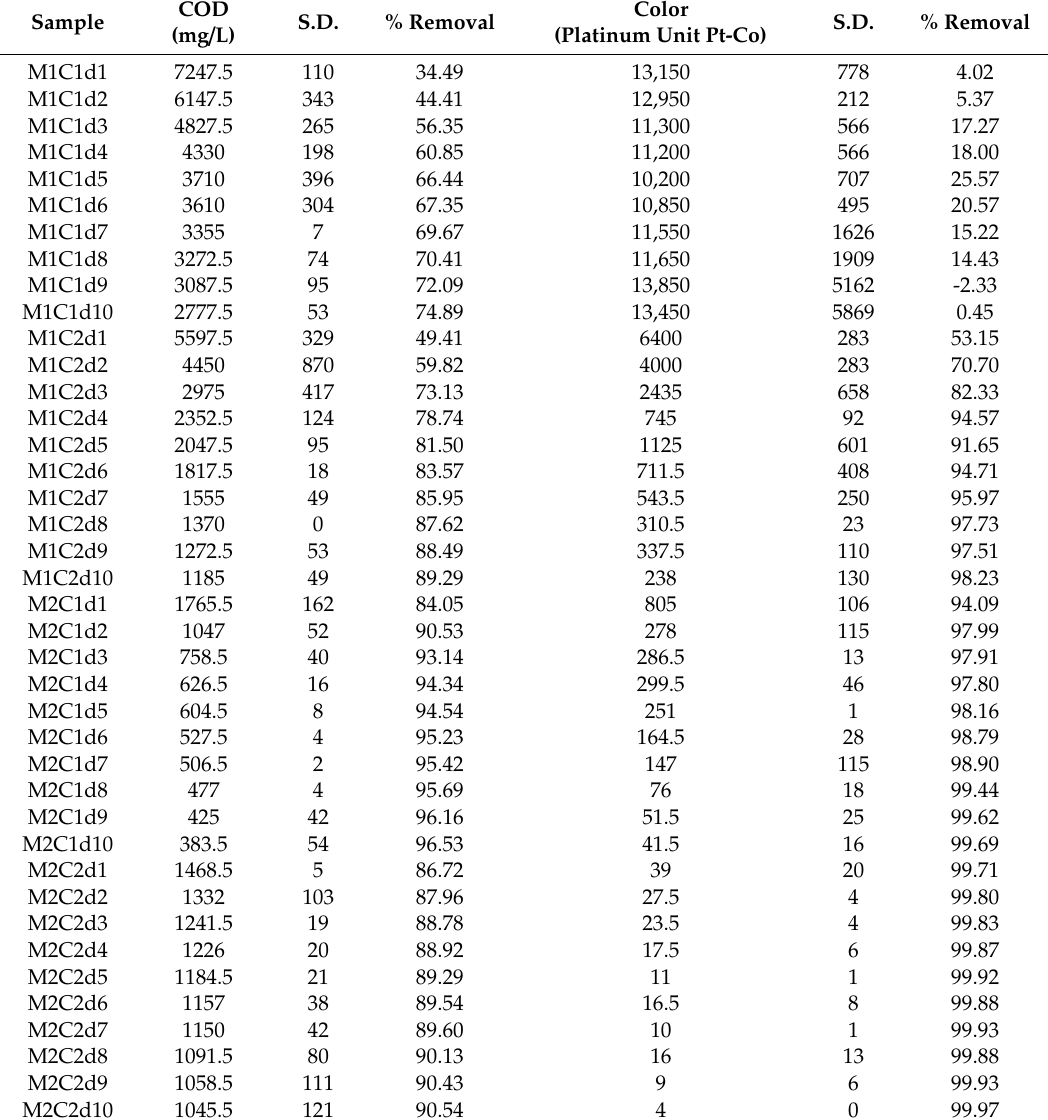
Table 1. Average test results for granular activated carbon (GAC) and powdered activated carbon